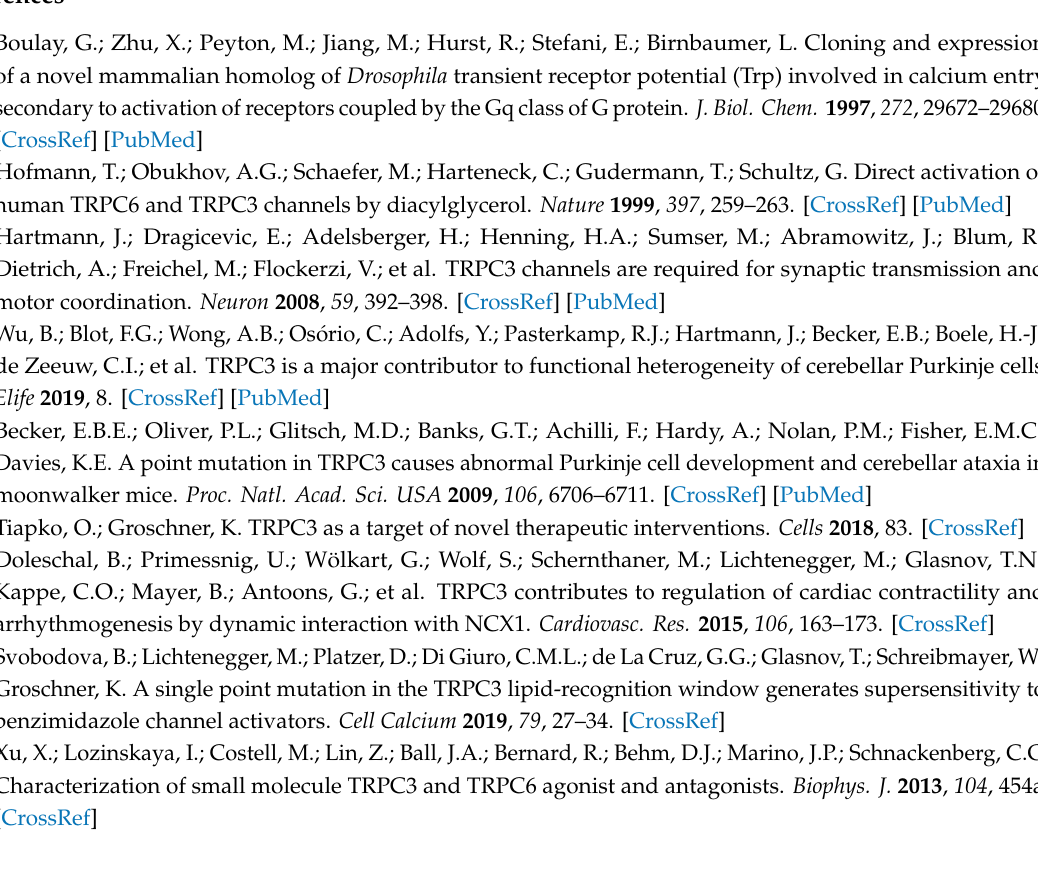
Figure S1: Selectivity of artemisinin e ff ects tested for various TRP channel